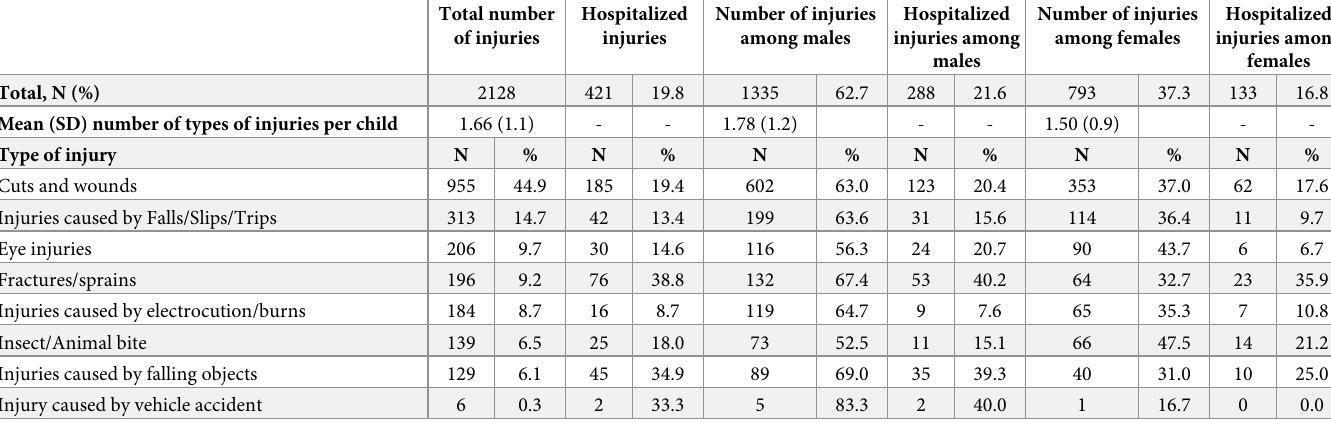
Table 4. Type of work-related injury and hospitalization among male and female Syrian refugee working children (8–18 years) in the Bekaa Valley, Lebanon, 2017 (N = 2128 �